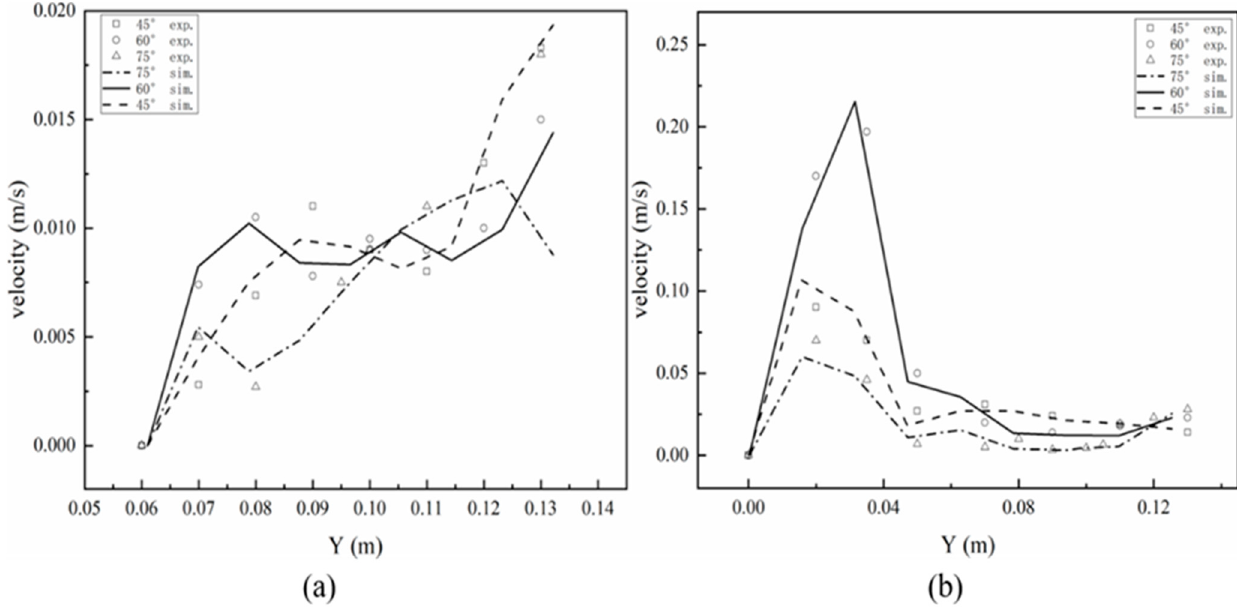
Figure 2. Comparison of the experimental and simulated liquid velocities along the Y -axis of the reactor under different baffle angles in the middle of the secondary settling zone ( a ) and settling zone ( b ) in R3 .